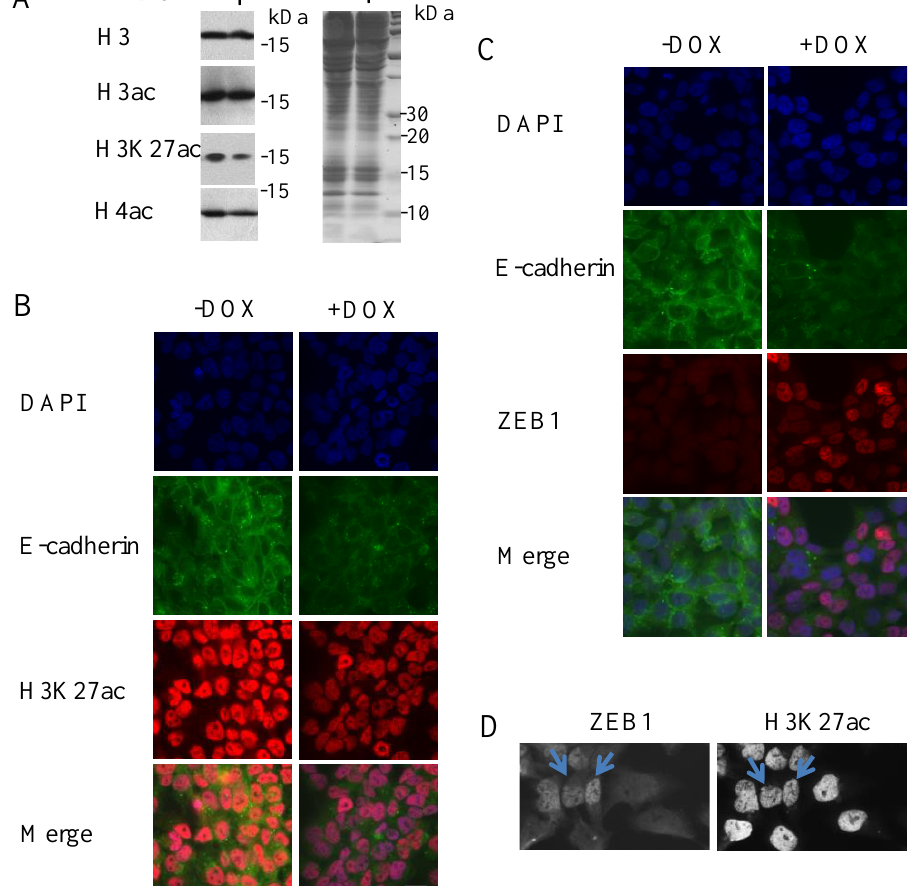
Figure 6. Histone H3K27 acetylation: a mark of ZEB1 induction. H358 FlipIn ZEB1cells were grown for 48 h in the absence (−) or in the presence (+) of DOX. ( A ) Western blot for H3, H3 acetylation, H3K27 acetylation, and H4 acetylation. H3 staining is the loading control. Protein molecular weights are indicated in kDa. This blot is representative of three independent experiments (left panel). Protein staining with Coomassie blue is on the right. ( B ) Immunocytochemistry for H3K27 acetylation (red) in H358 FlipIn ZEB1cells with E-cadherin (green) as a read-out for ZEB1 induction. E-cadherin staining was performed with the mouse anti-E-cadherin. Blue color indicates DAPI nuclear staining. One image is reported and representative of two independent experiments with three pictures taken for each well. Bar scale: 40 µM. ( C , D ) E-cadherin, detected with the mouse anti-E-cadherin- antibody, is a read-out of ZEB1 expression: ( C ) Co-immunostaining for E-cadherin and ZEB1(detected with the rabbit ZEB1-antibody) in H358 FlipIn ZEB1 cells without and with DOX. E-cadherin staining was decreased when ZEB1 was induced and detected with the rabbit antibody. ( D ) Additional control for co-staining of ZEB1 and H3K27ac. H3K27 acetylation (detected with the rabbit H3K27ac-antibody) was performed with ZEB1 stained with the mouse antibody in ZEB1-induced H358 cells. H3K27 acetylation staining is less intense in positive ZEB1 stained cells as indicated by arrows. Six pictures were taken per well and one representative image is